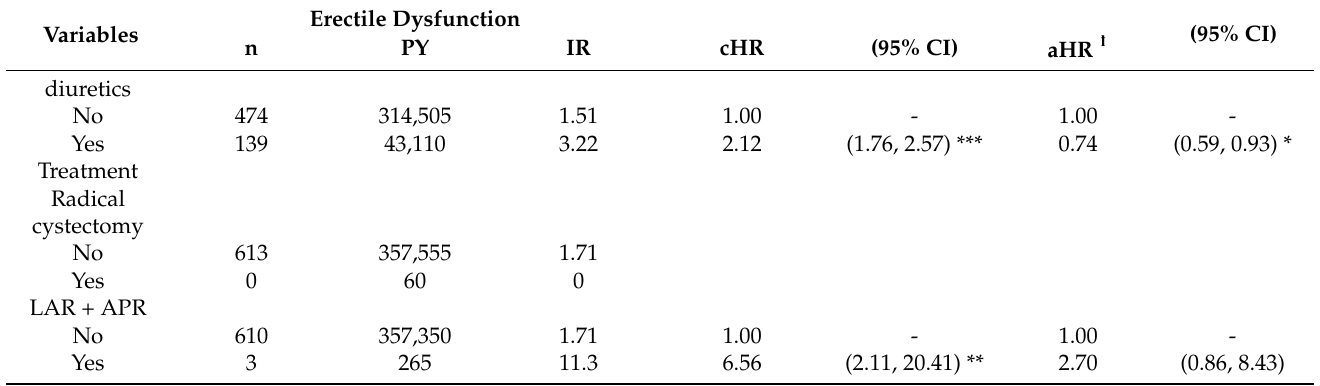
Table 3. The association of explanatory variables and the risk of erectile dysfunction.